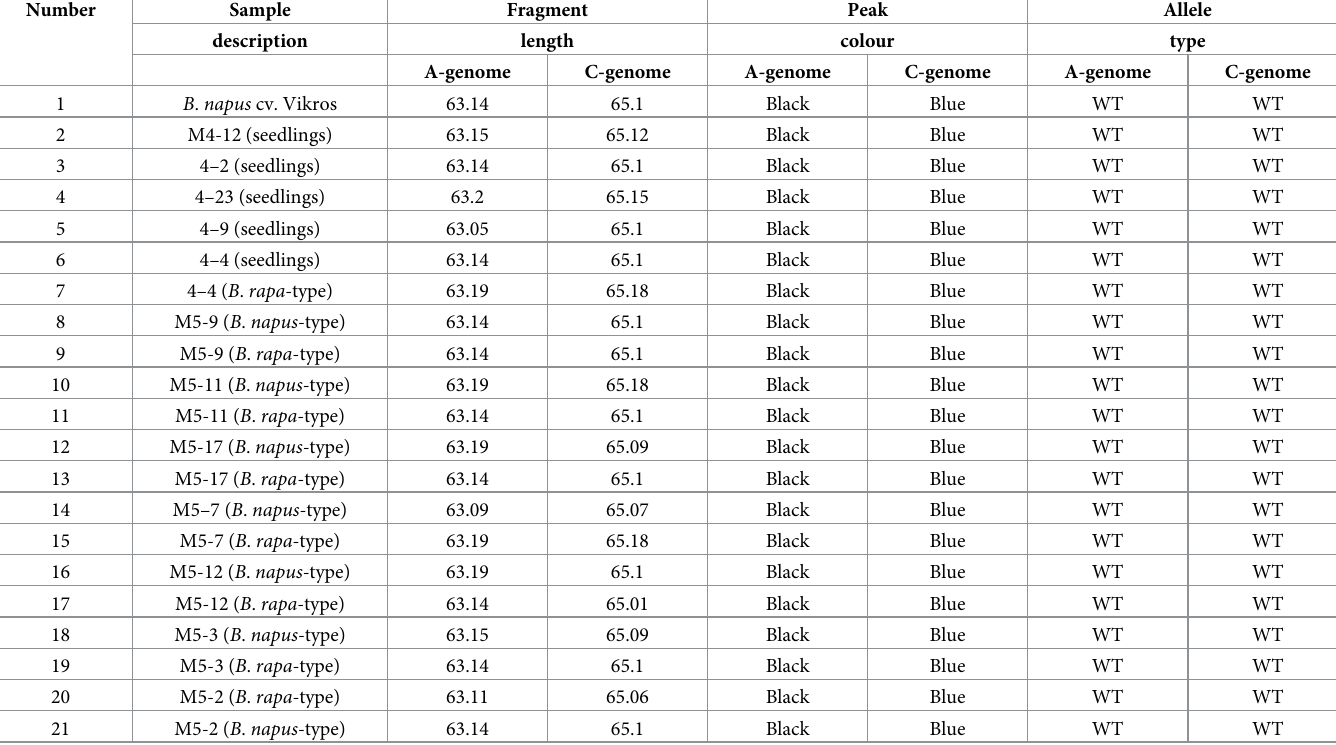
Table 3. The results of SNaPshot detection of mutant and wild-type alleles of FAD3 genes in B . napus cv. Vikros and M4-M5 plants. Number Sample